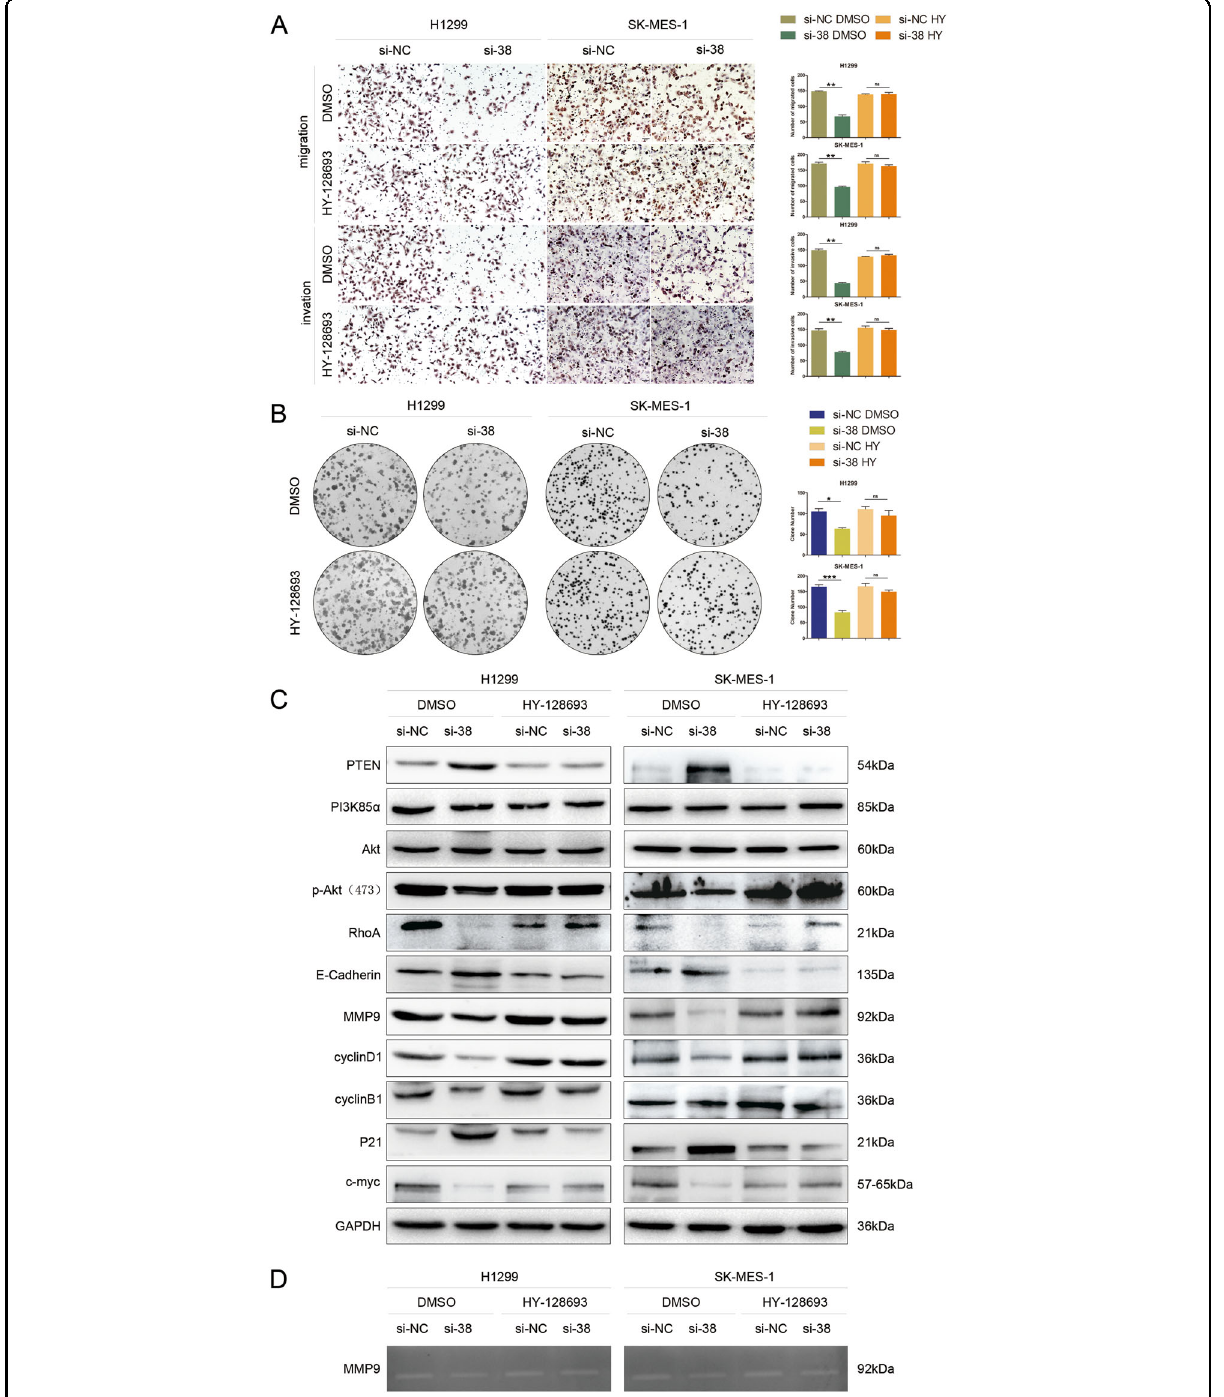
Fig. 4 Effect of KLHL38 expression with or without PTEN inhibition on non-small cell lung cancer (NSCLC) cells. A Migration, invasion, and B colony formation assays of H1299 and SK-MES-1 cells transfected with a KLHL38 -speci fi c siRNA were reversed upon incubation with the PTEN inhibitor HY-128693, compared to DMSO treated cells. C Expression of proteins involved in cell proliferation, migration, invasion, and the Akt signaling in A549, H1299, and SK-MES-1 cells transfected with a KLHL38 -speci fi c siRNA upon treatment with DMSO or the PTEN inhibitor HY-128693. si-NC, cells transfected with scrambled control siRNA; si-38, cells transfected with KLHL38 -speci fi c siRNA. D Gelatin zymograph assay showing the changes of secreted active MMP9. All experiments were repeated three times, error bars as